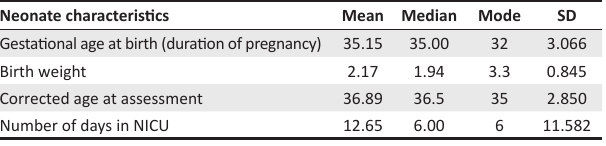
TABLE 1: Participant characteristics ( n =